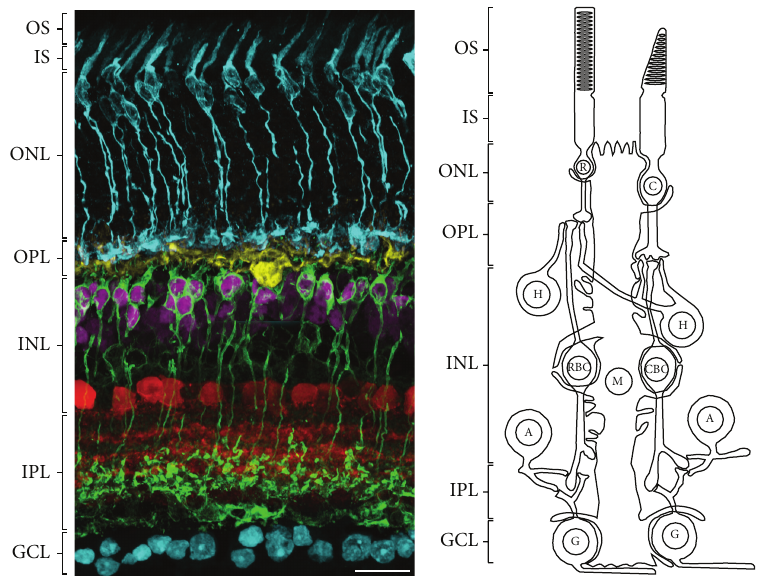
Figure 1: Schematic illustration representing the organization of the mouse retina. Rod (R) and cone (blue/C) photoreceptors have their cell bodies in the outer nuclear layer (ONL) and extend inner (IS) and outer (OS) segments. Photoreceptors axons synapse in the outer plexiform layer (OPL) with horizontal (yellow/H) and bipolar (magenta/RBC-CBC) cells. The inner nuclear layer (INL) also contains amacrine (red/A) and M¨uller cells (M). Bipolar cells synapse to amacrine and ganglion (blue/G) cells in the inner plexiform layer (IPL). Ganglion cell axons form the optic nerve in the ganglion cell layer (GCL) and carry signals to the brain.